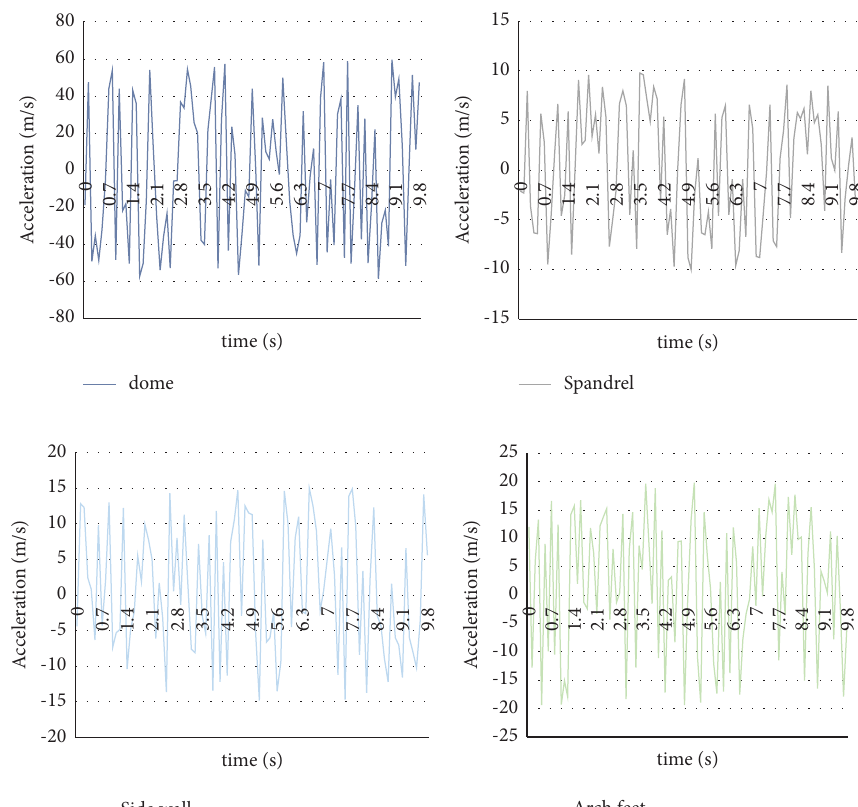
Figure 8: Acceleration time-history curve of each observation point of the conventional section of the upper-span tunnel.